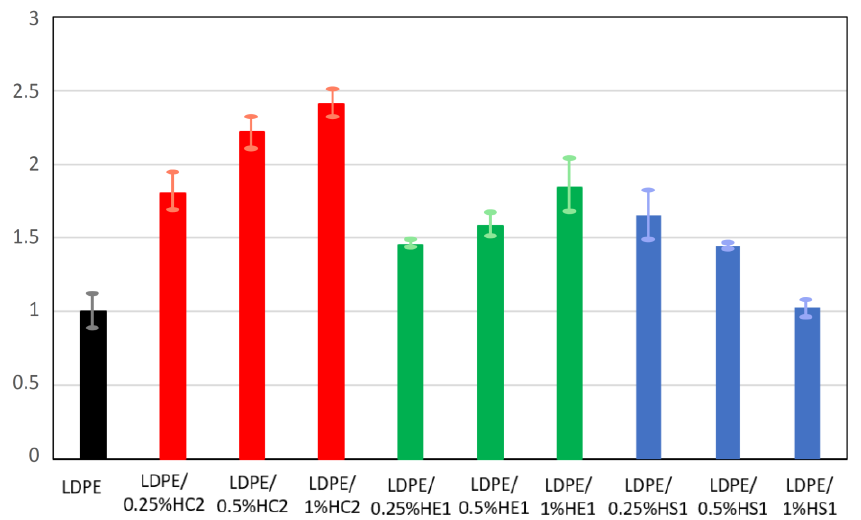
Figure 11. Relative elongation at break of LDPE and LDPE/hematite composites.